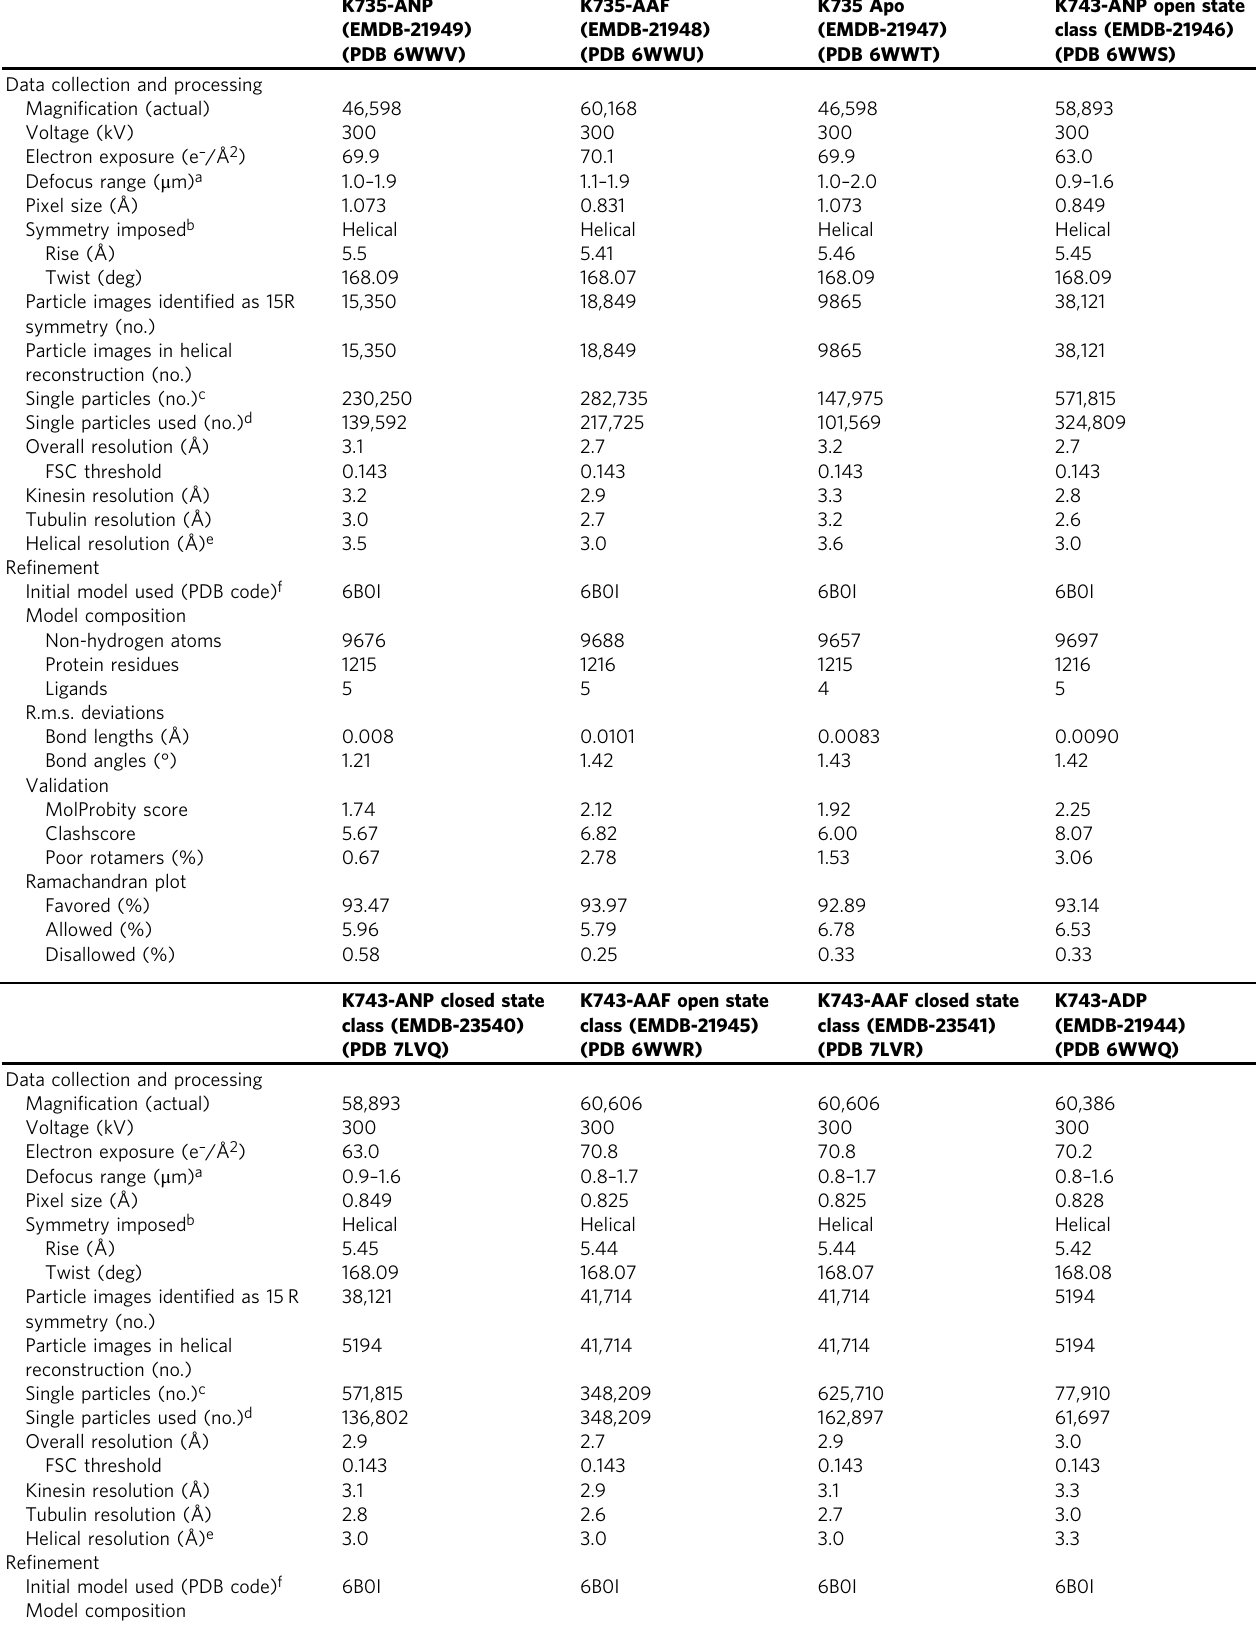
Table 1 Cryo-EM data collection, re fi nement, and validation